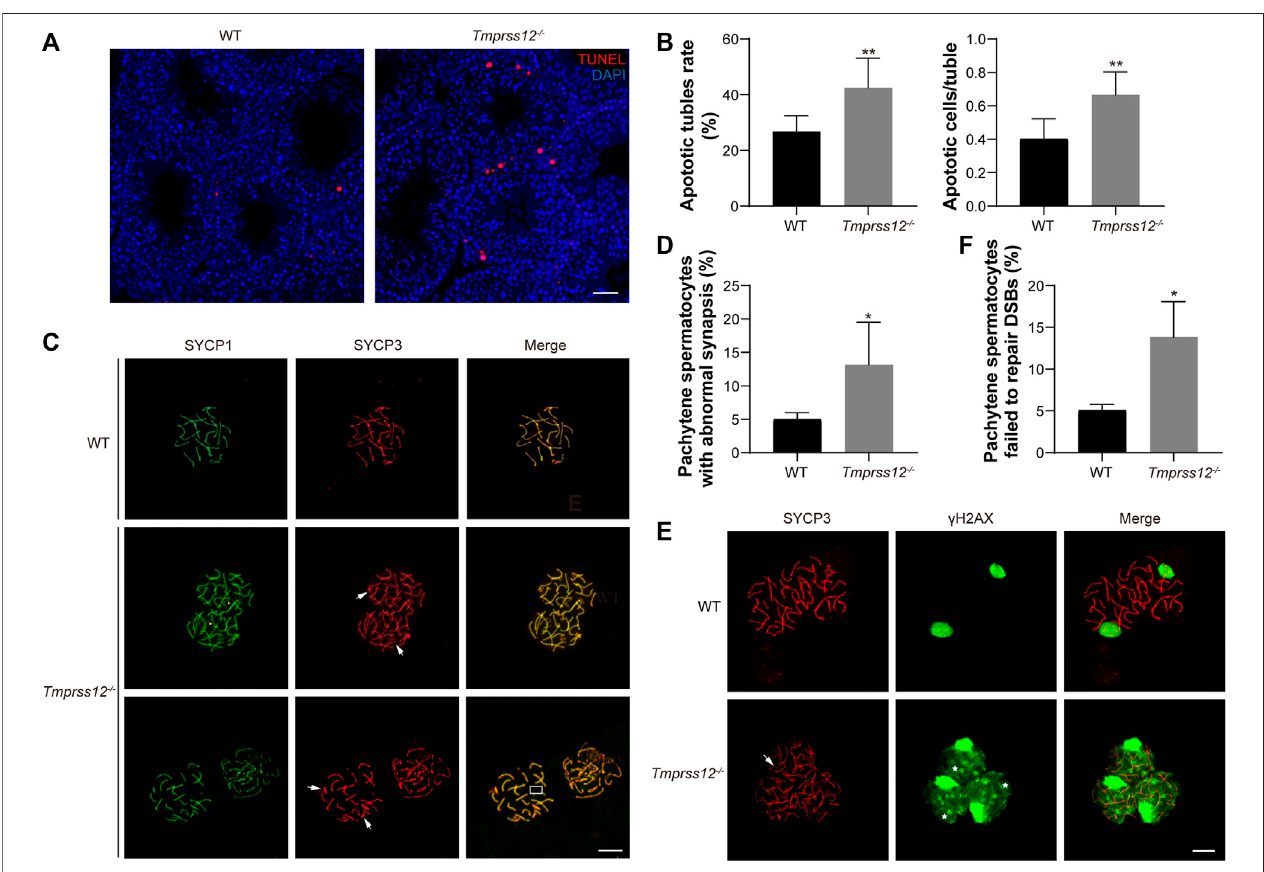
FIGURE 4 | Tmprss12 deletion leads to damaged synapsis and DSB repair in meiosis. (A) Terminal deoxynucleotidyl transferase nick-end-labelling (TUNEL) staining (red) in the testes. Apoptosis in Tmprss12 − / − mice was signi fi cantly increased, and the apoptotic cells were mainly spermatocytes. Nuclei are stained with DAPI (blue).Scalebar:50 µm. (B) Analysisoftheapoptotictubulerateandthenumberofapoptoticcellspertubule.Allspermatogenictubulesfromtestissectionsofthesame size in two groups were observed. The data showed increased apoptosis in Tmprss12 − / − mouse testes ( n = 3). Data are the mean ± s.d. pp p < 0.01. (C) Immuno fl uorescence staining of SYCP1 and SYCP3 on spermatocyte spreads produced from WT and Tmprss12 − / − mouse testes. Chromothripsis (white arrows), no synapsed sex chromosomes (boxed area), and abnormal SYCP1 signals in non-PAR (yellow arrows) were observed in Tmprss12 − / − mice. Scale bars: 10 µm. (D) Percentage of pachynema spermatocytes with abnormal synapses. The quantitative value was increased in Tmprss12 − / − mice ( n = 3). Data are the mean ± s.d. p p < 0.05. (E) Immuno fl uorescence staining of SYCP3 and γ H2AX on spermatocyte spreads produced from adult WT and Tmprss12 − / − mouse testes. In Tmprss12 − / − images,whitearrowsindicatechromothripsis, andasterisksindicate theabnormal γ H2AXsignal.Scalebars:10 µm. (F) Statistical analysisshowingthatthepercentage of pachytene spermatocytes with abnormal DSB repair was increased compared with that in WT mice ( n = 3). Data are the mean ± s.d. p p < 0.05.